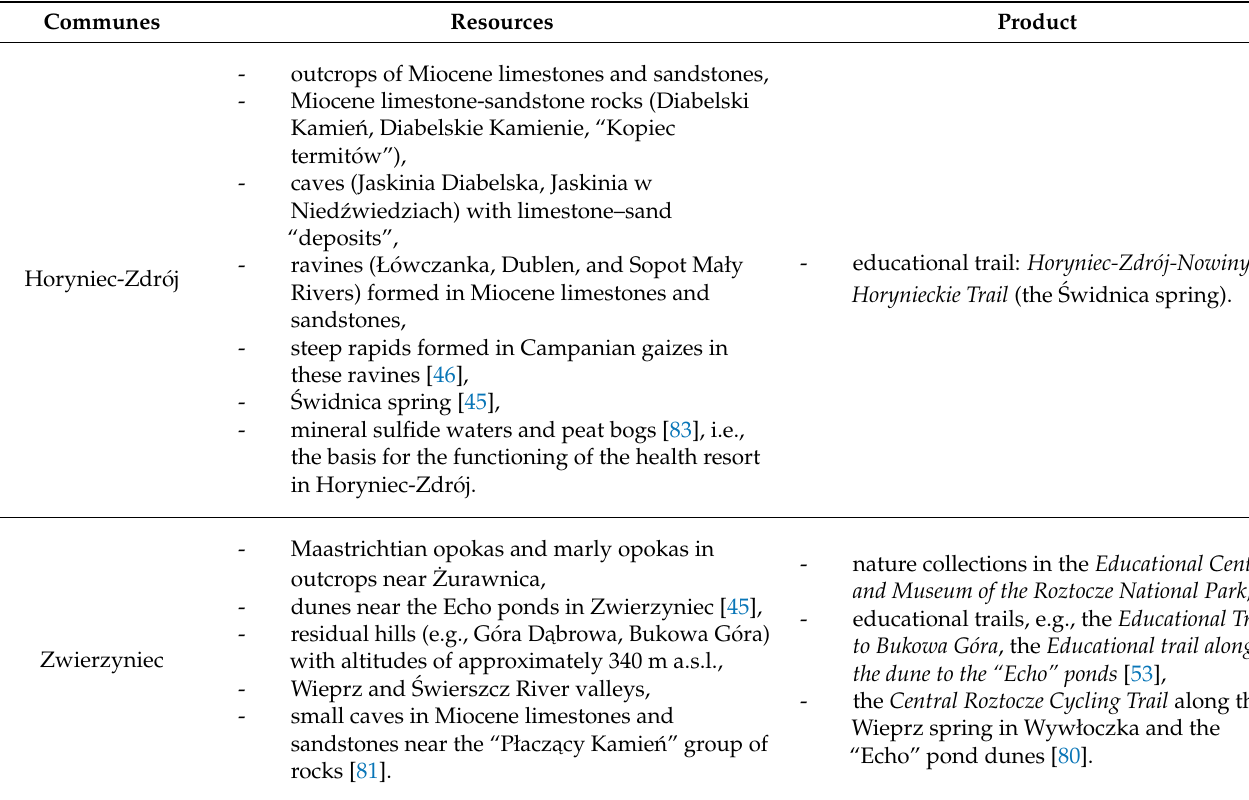
Table 8. Resources and products with high geotourism potential (TIGP = 0.123–0.183) in the communes.